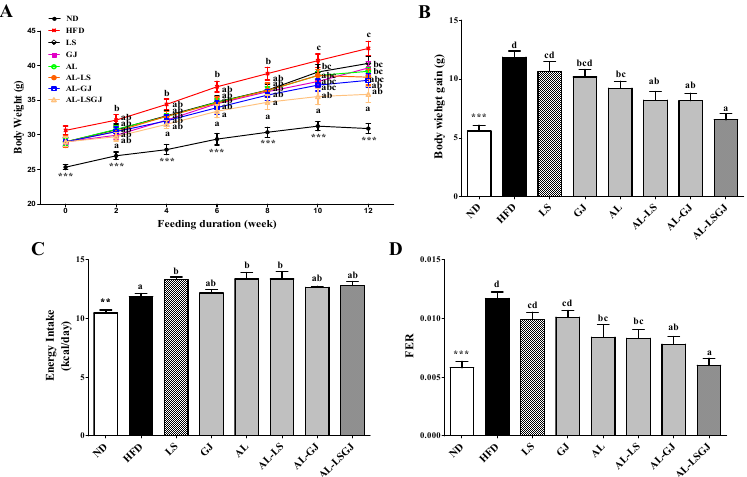
Figure 1. Effect of synbiotic supplementation for 12 weeks on body weight, measured weekly. ( A ) body weight, ( B ) body weight gain, ( C ) energy intake and ( D ) food deficiency ratio (FER) in diet-induced obese mice. Data represented as mean ± standard error of the mean (S.E.); Significant differences ND versus HFD are indicated; ** p < 0.01, *** p < 0.001; abcd Means with different superscript letters are significantly different among the groups ( p < 0.05); ND: normal diet (5% fat, w/w ); HFD: high fat diet (20% fat, 1% cholesterol, w/w ); LS: HFD + Lactobacillus sakei LS03 10 9 cfu/day; GJ: HFD + Leuconostoc kimchi GJ2 10 9 cfu/day; AL: HFD + 3% allulose; AL-LS: AL + Lactobacillus sakei LS03 10 9 cfu/day; AL-GJ: AL + Leuconostoc kimchi GJ2 10 9 cfu/day; AL-LSGJ: AL + Lactobacillus sakei LS03 + L. Leuconostoc kimchi GJ2 10 9 cfu/each/day; FER: food efficiency ratio = body weight gain / energy intake per day.